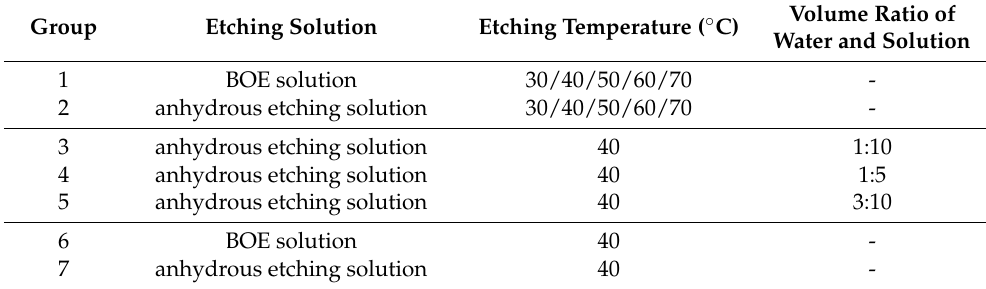
Table 2. Etching conditions of each group.